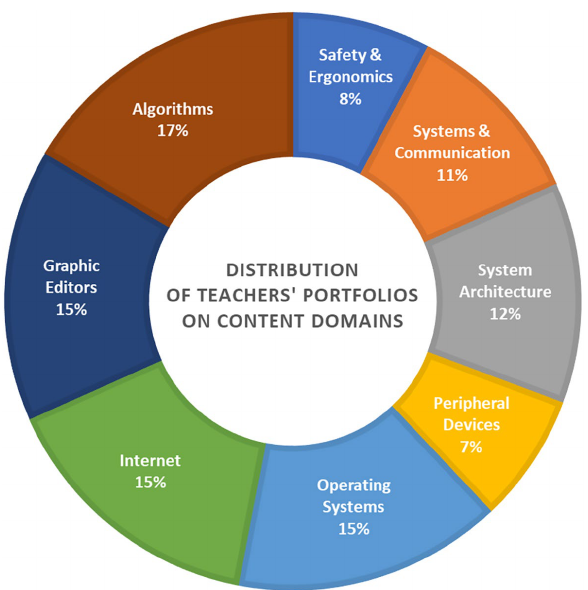
Figure 1. Distribution of teachers’ portfolios based on the content domains they